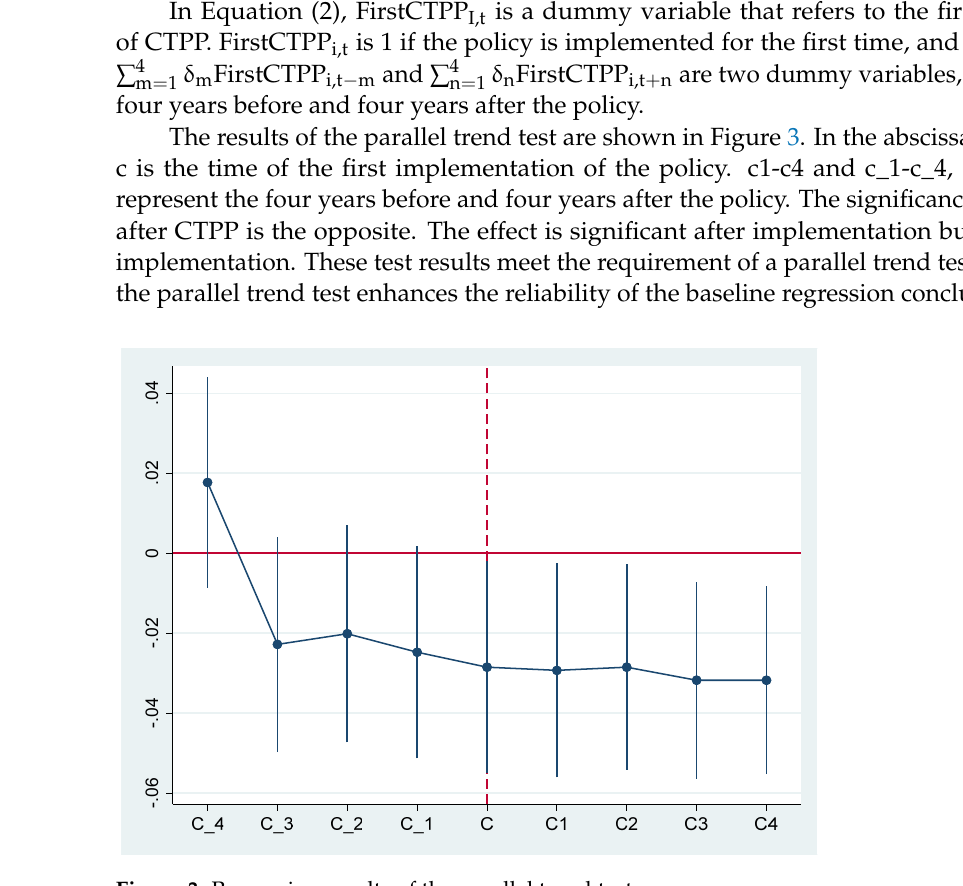
Figure 3. Regression results of the parallel trend test. Table 2. Benchmark regression